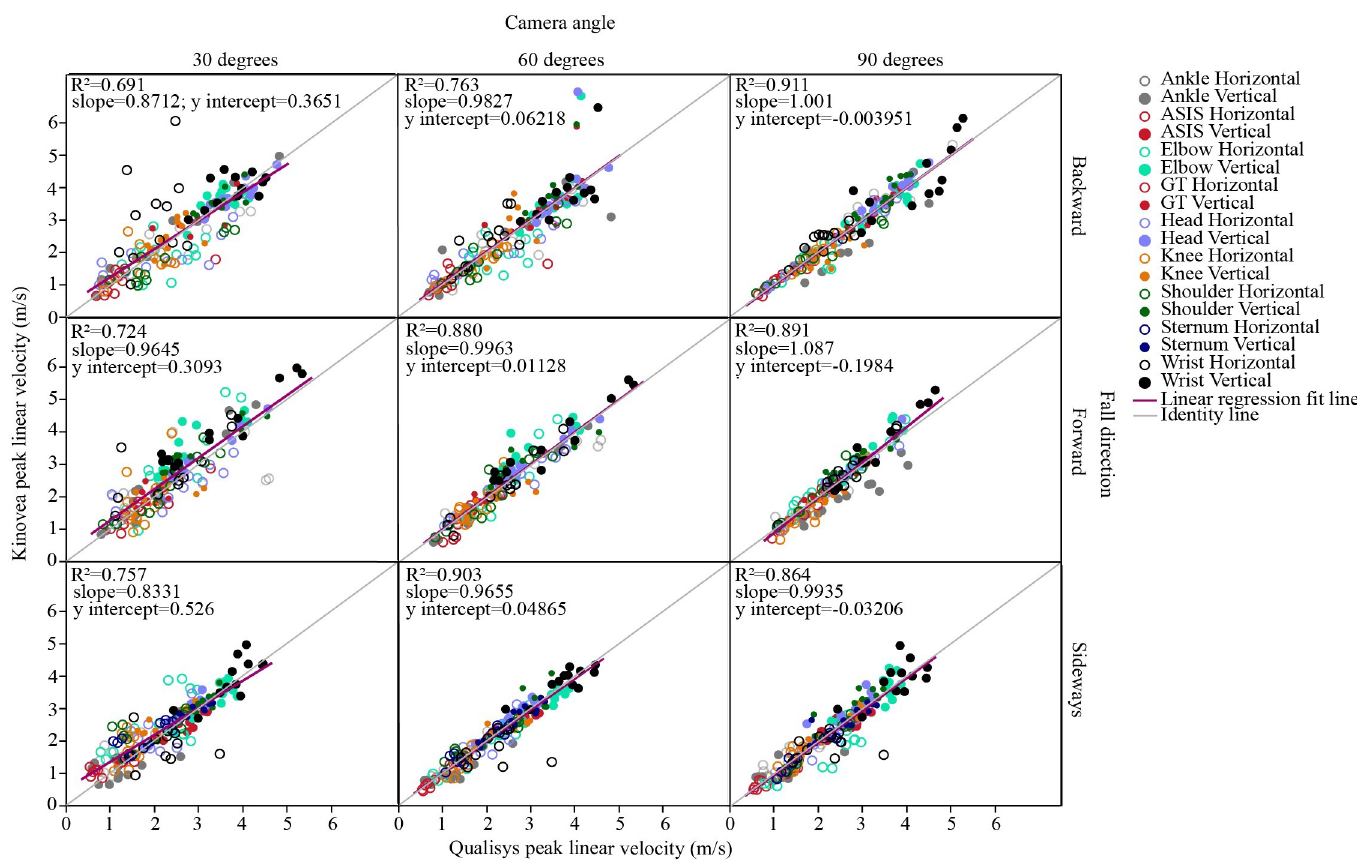
Fig 6. Effects of camera angle and fall direction on agreement between Kinovea and Qualisys peak velocities. The graphs compare peak vertical and horizontal velocities for various anatomical locations. Results are specific to the calibration grid located in the plane of the fall and Kinovea velocities differentiated from position data filtered with a cut-off frequency of 10